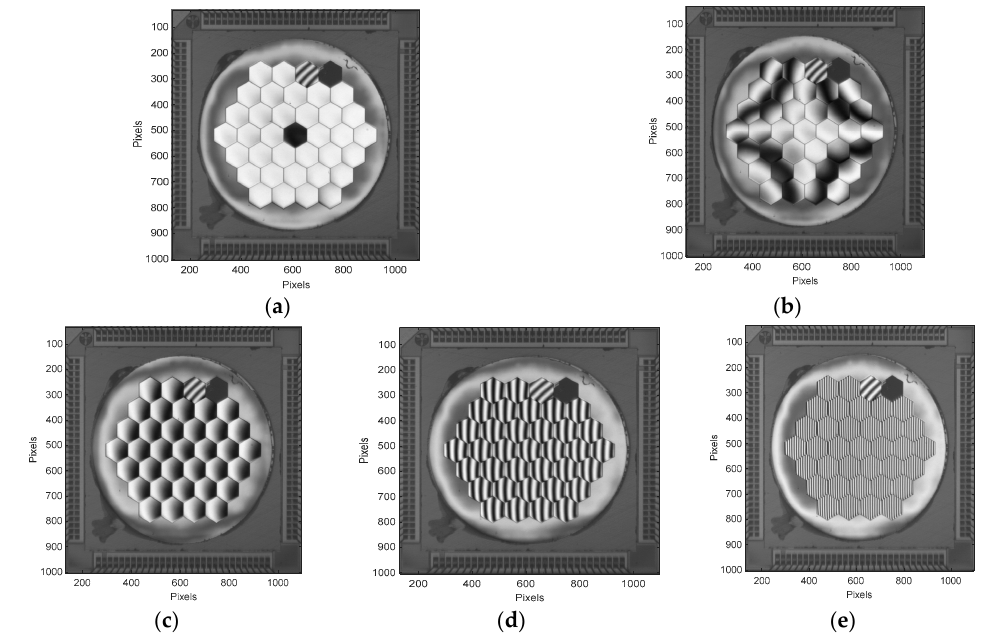
Figure 8. ( a ) 150 nm piston on segment#1; ( b ) astigmatism (0.125 on Zernike coefficient); ( c – e ) Increasing tilt values along the X direction are applied to all segments (0.25, 1.5 and 4.9 mrad).